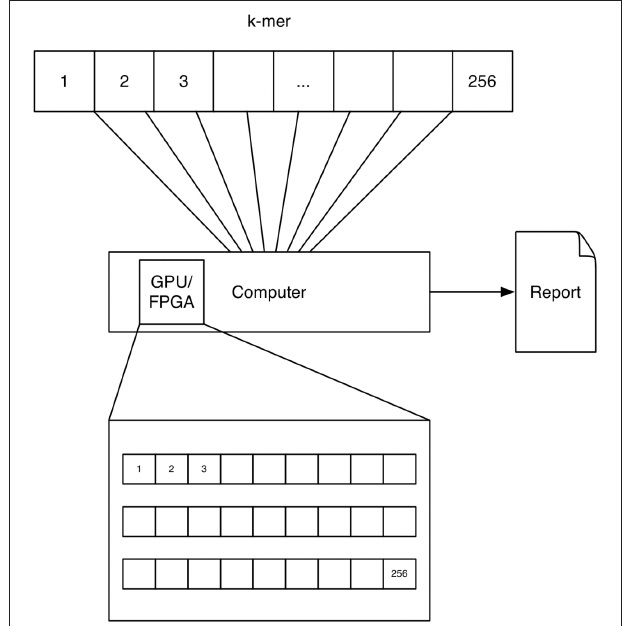
FIGURE 3 | GPU/FPGA: The concept of GPU and FPGA computing of k -mers is similar, as both devices feature a multitude of processors. Here the task is distributed to these processors by computing one k -mer on each processor. Note that for FPGAs a multitude of approaches exist for solving this problem and this solution is only represented as one